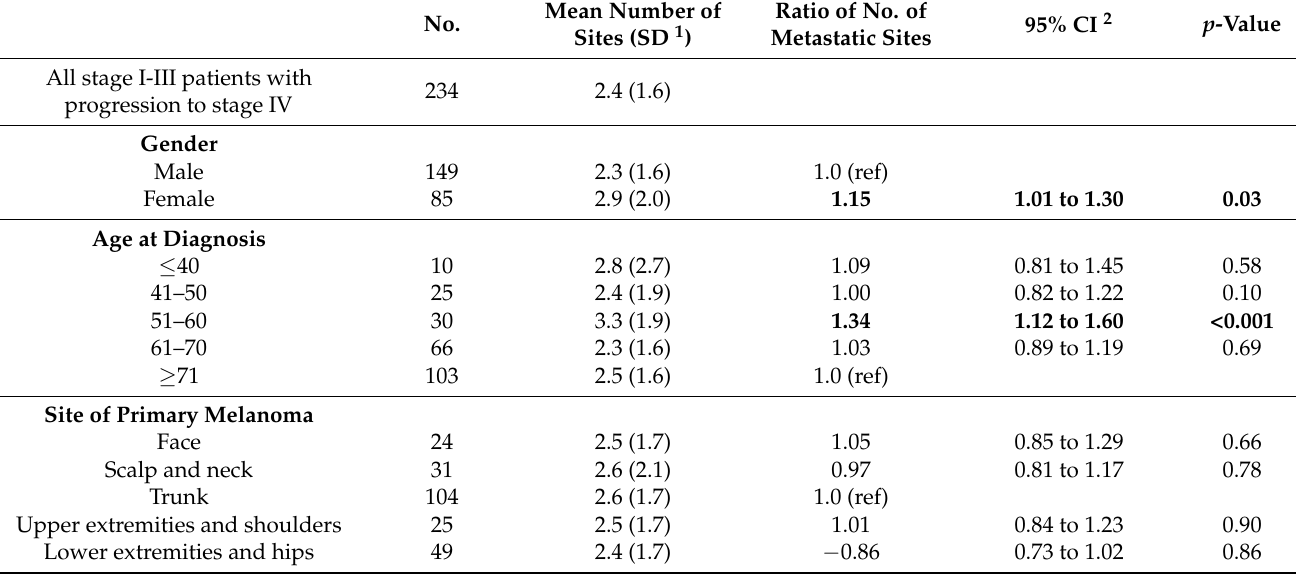
Table 5. The mean number of metastatic organ sites with distant metastases at first presentation of stage IV disease in relation to patient and tumour characteristics in patients diagnosed with a single stage I–III primary melanoma between July 2017 and December 2019 in a multivariate